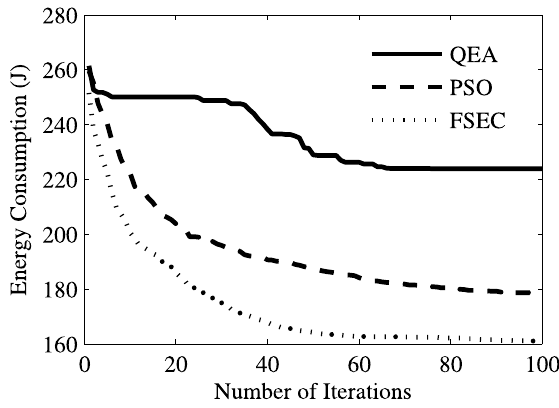
Figure 3: The communication energy consumption by iteration with 300 nodes and cluster head pro- portion of 10%